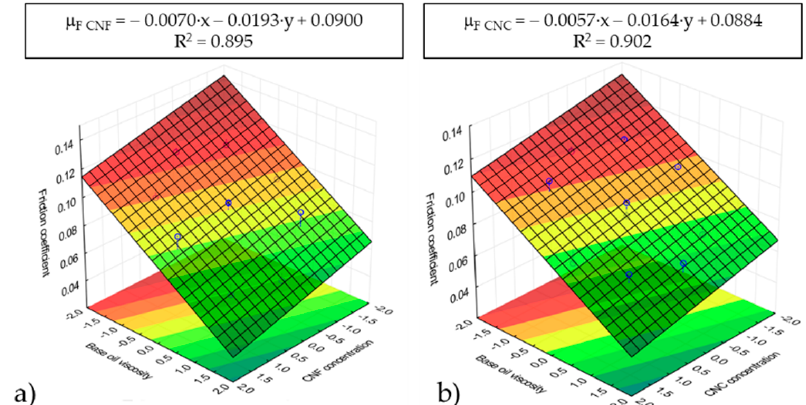
Figure 8. Response surface analysis (RSM) based on friction coefficients for CNF ( a ) and CNC ( b ) ecolubricants.